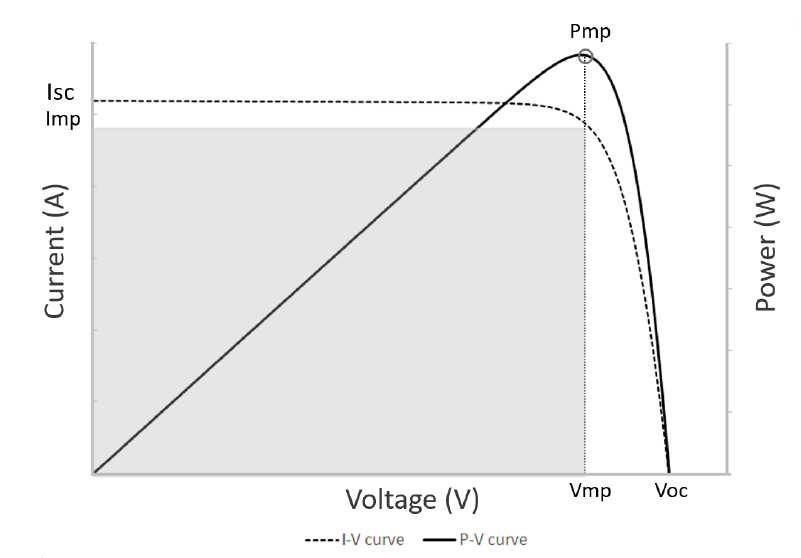
Figure 2. Ideal shape of solar cell I-V and P-V characteristic curves. The I-V curve also shows parameters that represent the efficiency ( η ) and fill factor ( FF ) of the cell, which indicates how efficient the cell is at power conversion. The efficiency is defined by the relation between the maximum power generated ( I max × V max ) and the total irradiance incident on the area of the cell, as can be seen in Equation (1). The fill factor represents the quality of the solar cell. It is obtained by the relation between the maximum power ( I max × V max ) and the theoretical power ( I sc × V oc ) as can be seen in Equation